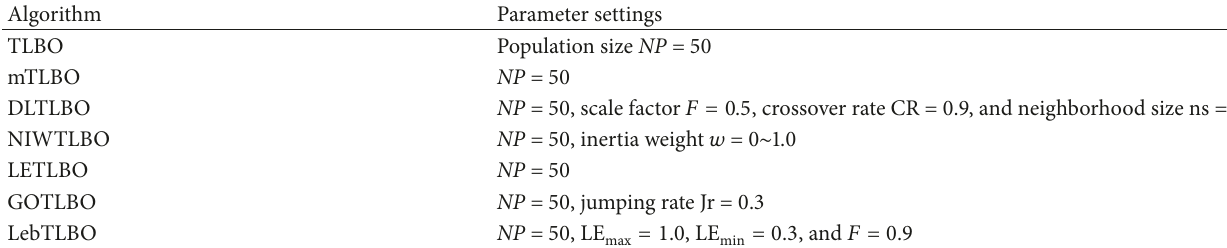
Table 1: Parameter settings for the compared TLBO algorithms.